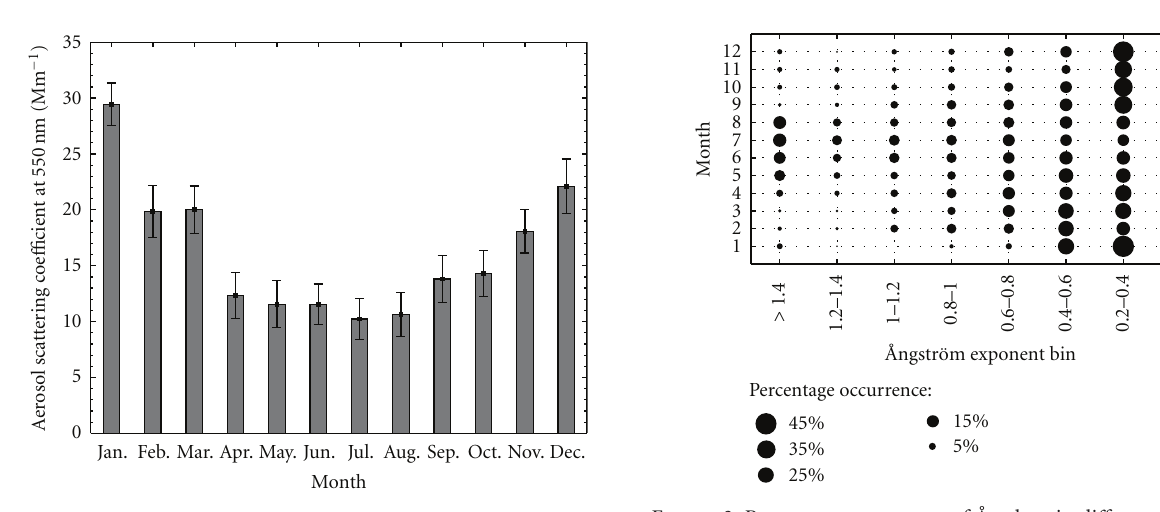
Figure 3: Percentage occurrence of ˚A values in di ff erent ˚Angstr¨om bins normalized over a month. Note: the ˚ Angstr ¨ om bin axis is reversed in